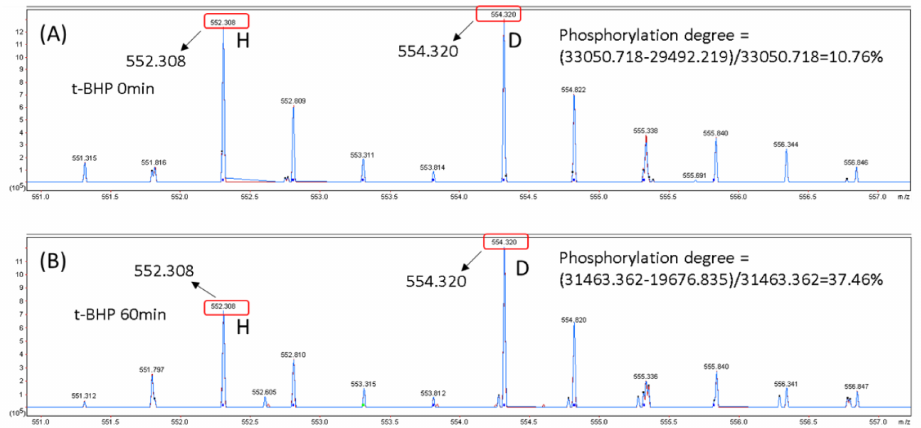
Figure 6. DM + deP determination of the phosphorylation degree di ff erence at Ser82 of heat shock protein Hsp27 derived from the HepG2 cells with and without t -BHP treatment. ( A ) The MS spectrum (LTQ Orbitrap) of *QLSSGVSEIR ( m / z 554.32 vs. m / z 552.30) without t -BHP treatment and ( B ) the MS spectrum (LTQ Orbitrap) of *QLSSGVSEIR after t -BHP treatment. “*” marks the dimethyl labeling site; “_” indicates the original phosphorylation